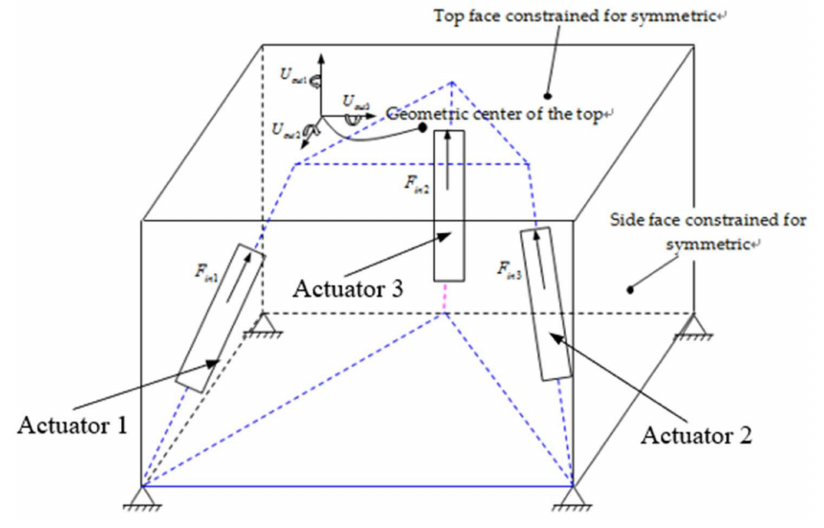
Figure 2. Initial design domain of the three-DOF spatially compliant